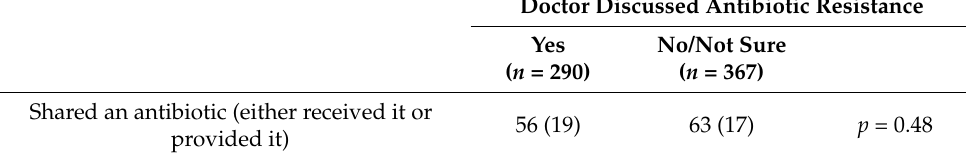
Table 4. Association between doctor and respondent conversations about antibiotic resistance and antibiotic use